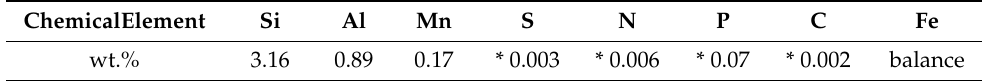
Table 1. Chemical composition of the investigated electrical steel measured by optical emission spectroscopy. S, N, P and C are either overestimated or below the detection limit of the method. Therefore, the maximum content based on supplier information (*) is provided.